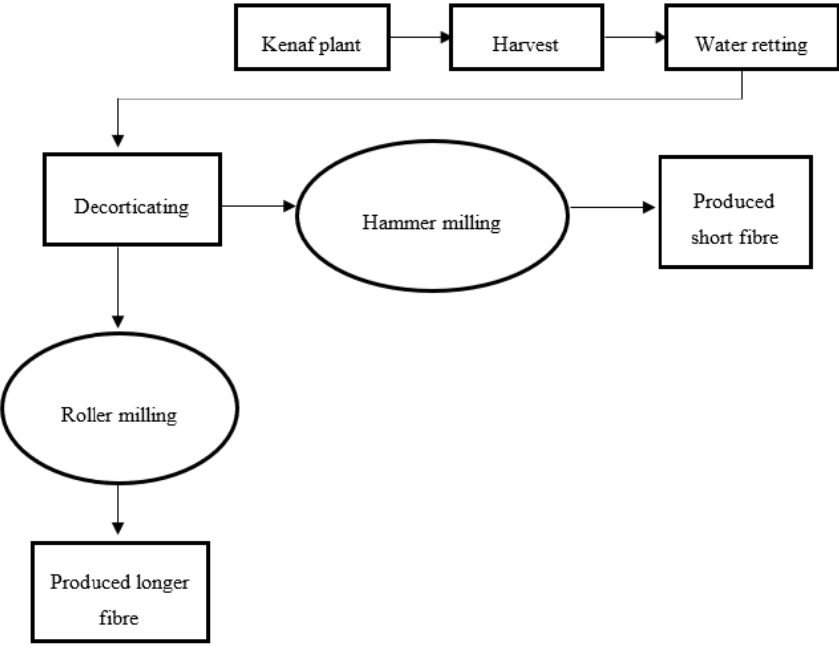
Figure 3. Fibre decortication process.